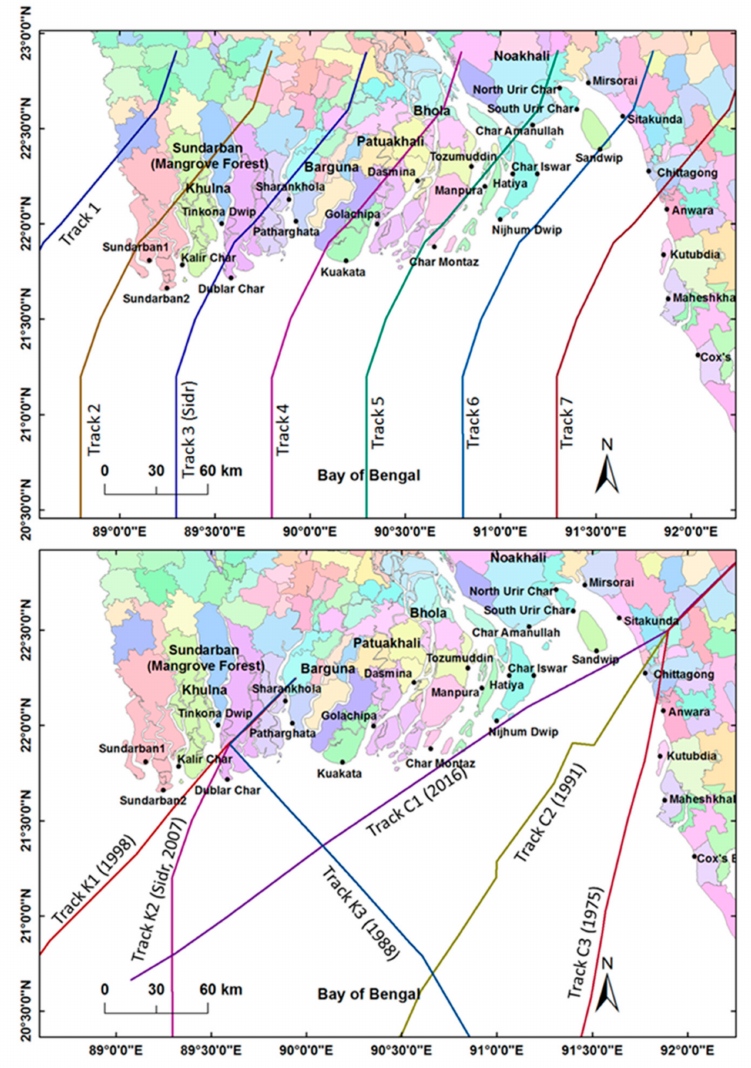
Figure 3. ( Upper panel ) seven hypothetical parallel cyclone tracks including the base case (Track 3: Cyclone Sidr); ( Lower panel ) three tracks each at the Khulna and Chittagong coasts for the investigation of coastline crossing